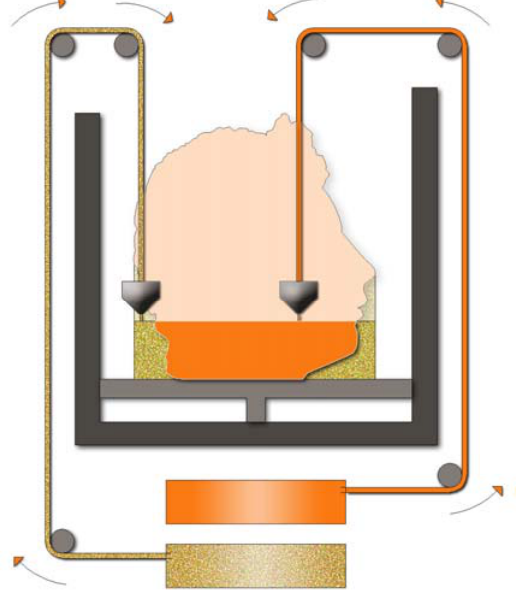
Figure 4. Schematic of the fused deposition modeling process